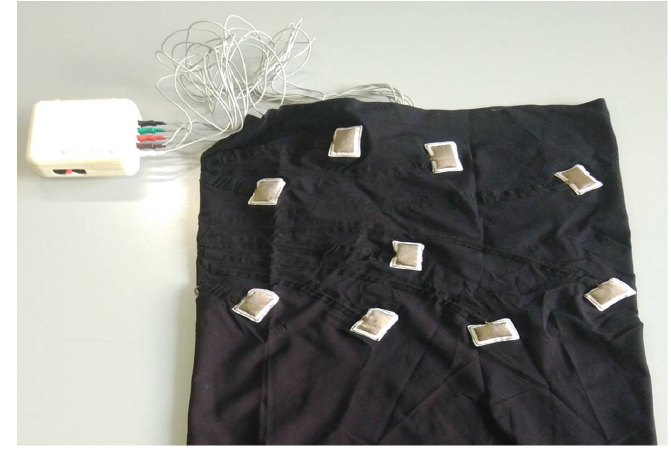
Figure 3. The new version of the bodysuit, viewed from the internal side.